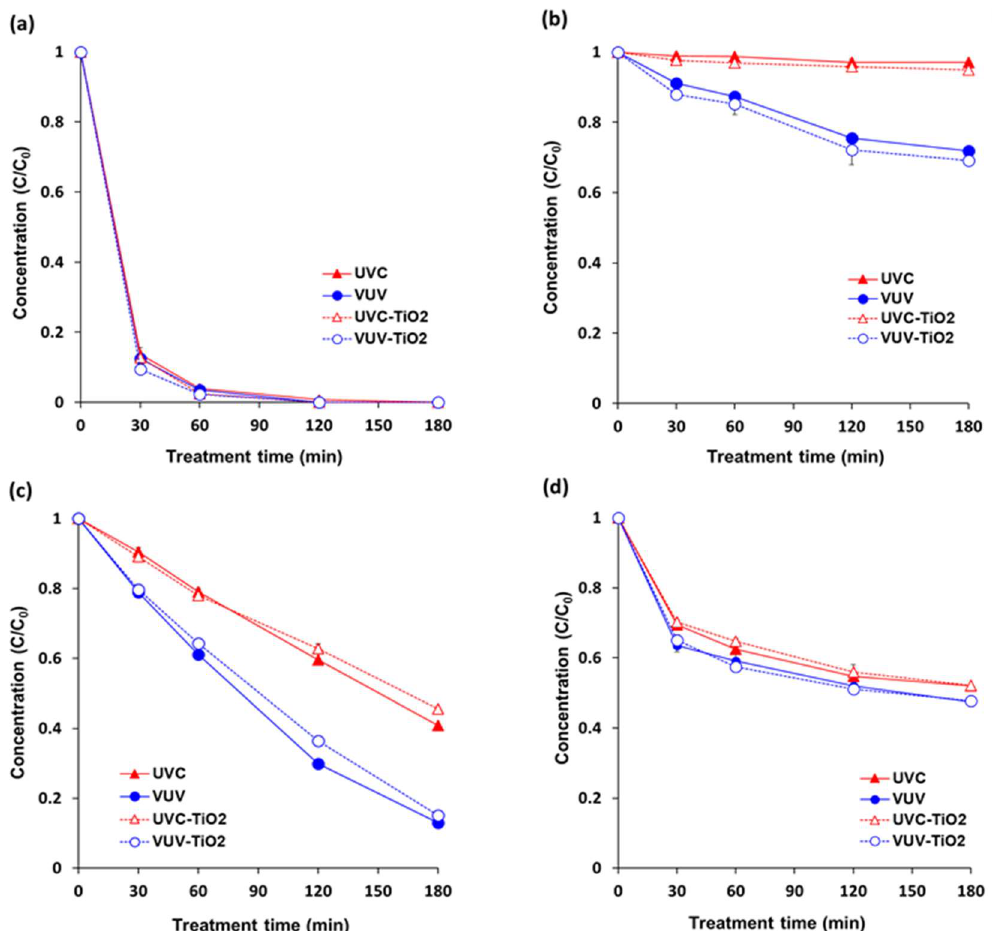
Figure 2. Degradation in individual pesticide solutions under different treatments. ( a ) pyraclostrobin; ( b ) boscalid; ( c ) fludioxonil; and, ( d ) azoxystrobin. The concentration of each single solution was 20 ppm ( w / v ). Sample solutions were continuously stirred with a magnetic stirrer at 300 rpm during treatment. UVC = UVC (254 nm) photolytic treatment; VUV = VUV (254 nm and 185 nm) photolytic treatment; UVC-TiO 2 = UVC-assisted TiO 2 photocatalytic treatment; VUV-TiO 2 = VUV-assisted TiO 2 photocatalytic treatment. Results represent the mean of three measurements ± standard deviation.